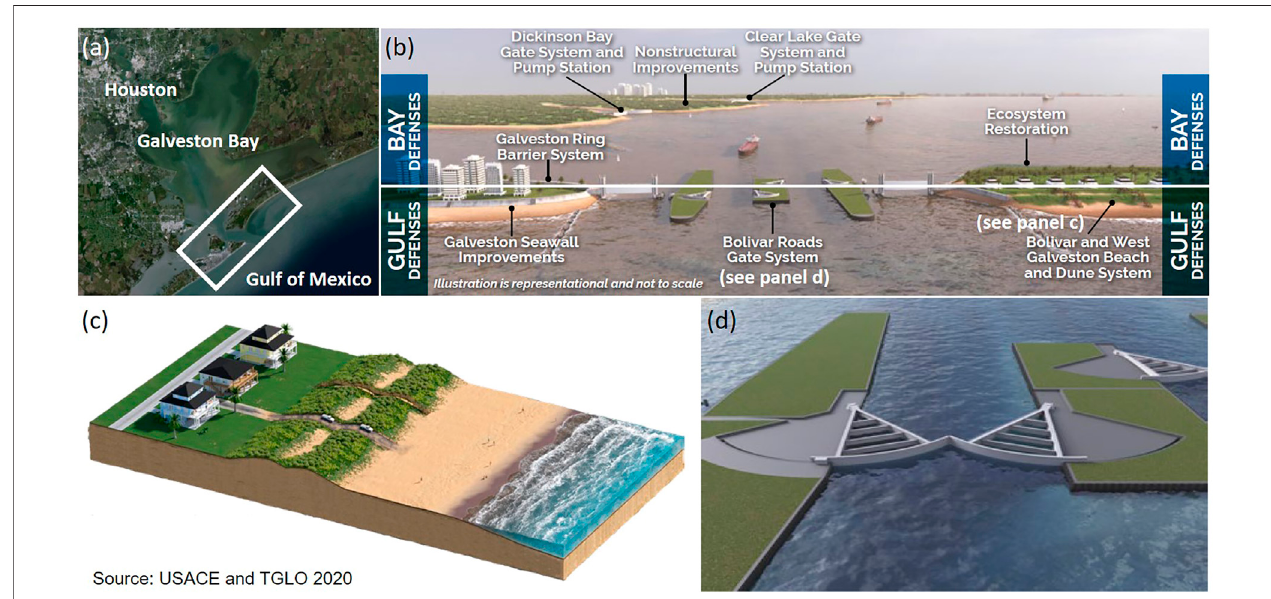
FIGURE 3 | (A) Overview of the Coastal Texas Study area. (B) The study proposes a multiple lines of defense approach for Galveston Bay that includes gulf defenses along the outer barrier island coast as well as bay defenses to provide residual risk reduction within the bay. The gulf defenses include (C) restored beach and dune systems along Bolivar Peninsula and (D) a gate system at Bolivar Roads, the primary connection between Galveston Bay and the Gulf of Mexico.